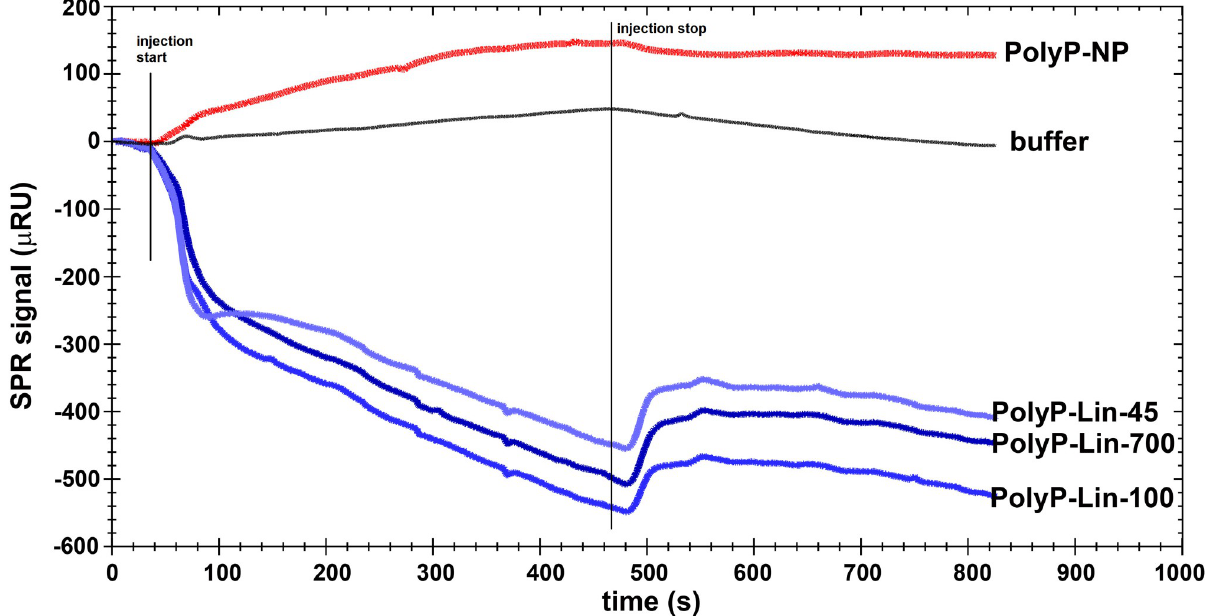
Fig 7. Representative SPR sensorgrams of the interaction of different polyphosphate forms and histone. Histone, non-covalently attached to a carboxymethyl-dextran surface, was exposed to a flow of polyphosphate of the indicated type at 1 mM concentration as described in Materials and methods. The nanoparticulate form of polyphosphate shows a small, but positive SPR signal, indicative of an ordinary weak interaction. In contrast, the linear polyphosphate forms strip the non-covalently bound histone from the chip, irrespective of their length.